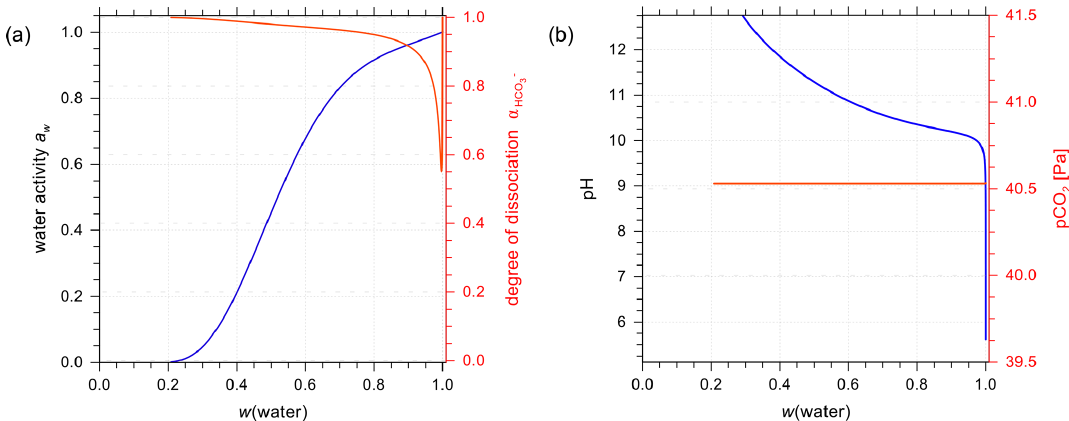
Figure 9. Open-system scenario with constant partial pressure of CO 2(g) at 298.15K. The liquid phase is an aqueous NaHCO 3 solution. (a) AIOMFAC predictions of water activity and degree of HCO − dissociation; (b) pH and partial pressure of CO 2 . 3